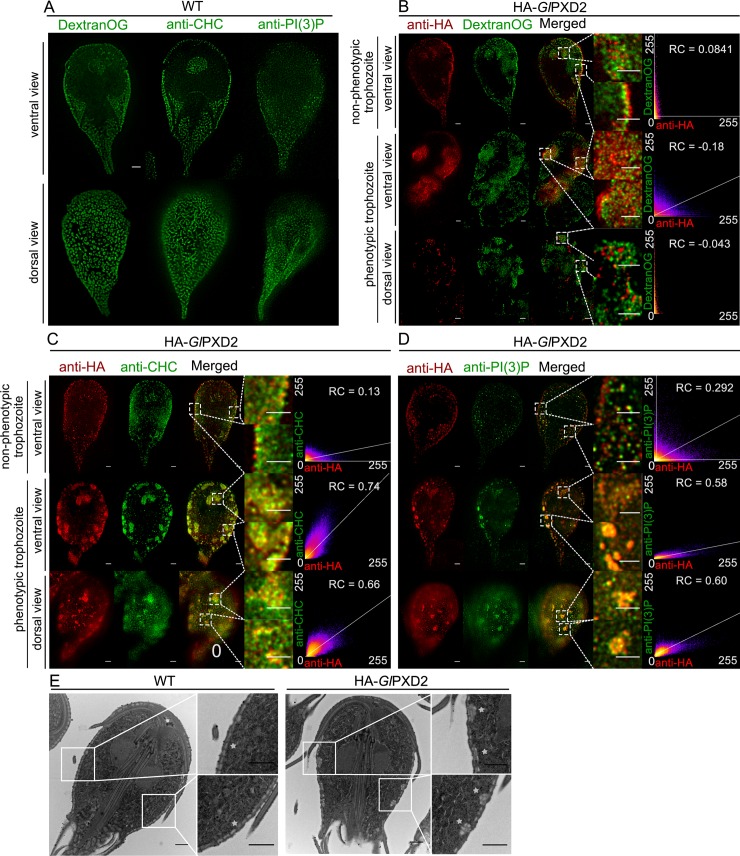
The impact of GlPXD2 ectopic expression on PV morphology.(A) STED-microscopy-based immunofluorescence analysis of ventral (upper panel) and dorsal (lower panel) views of representative non-transgenic wild-type cells labelled with Dextran-OG, anti-GlCHC (GlCHC) and anti-PI(3)P antibodies (PI(3)P) detects association of all markers to PVs. Insets: DIC images. Scale bars: 1 μm (B) STED-microscopy based immunofluorescence analysis of transgenic cells either weakly (upper panel, non-phenotypic trophozoite) or strongly (lower panels, phenotypic trophozoite) expressing an epitope-tagged GlPXD2 variant (HA-GlPXD2) and subjected to Dextran-OG uptake detects co-labelled PV-derived peripheral clusters which are also detected with (C) anti-GlCHC (GlCHC) and (D) anti-PI(3)P (PI(3)P) antibodies. Scale bars: single cells: 1 μm; merged insets: 1 μm. (E) tEM experiments detect peripheral PV-associated membranous clusters in cells expressing a tagged GlPXD2 variant (HA-GlPXD2; upper panel and insets) which were not detected in non-transgenic cells (WT; lower panel and insets). Scale bars: single cells: 1 μm; insets: 1 μm.